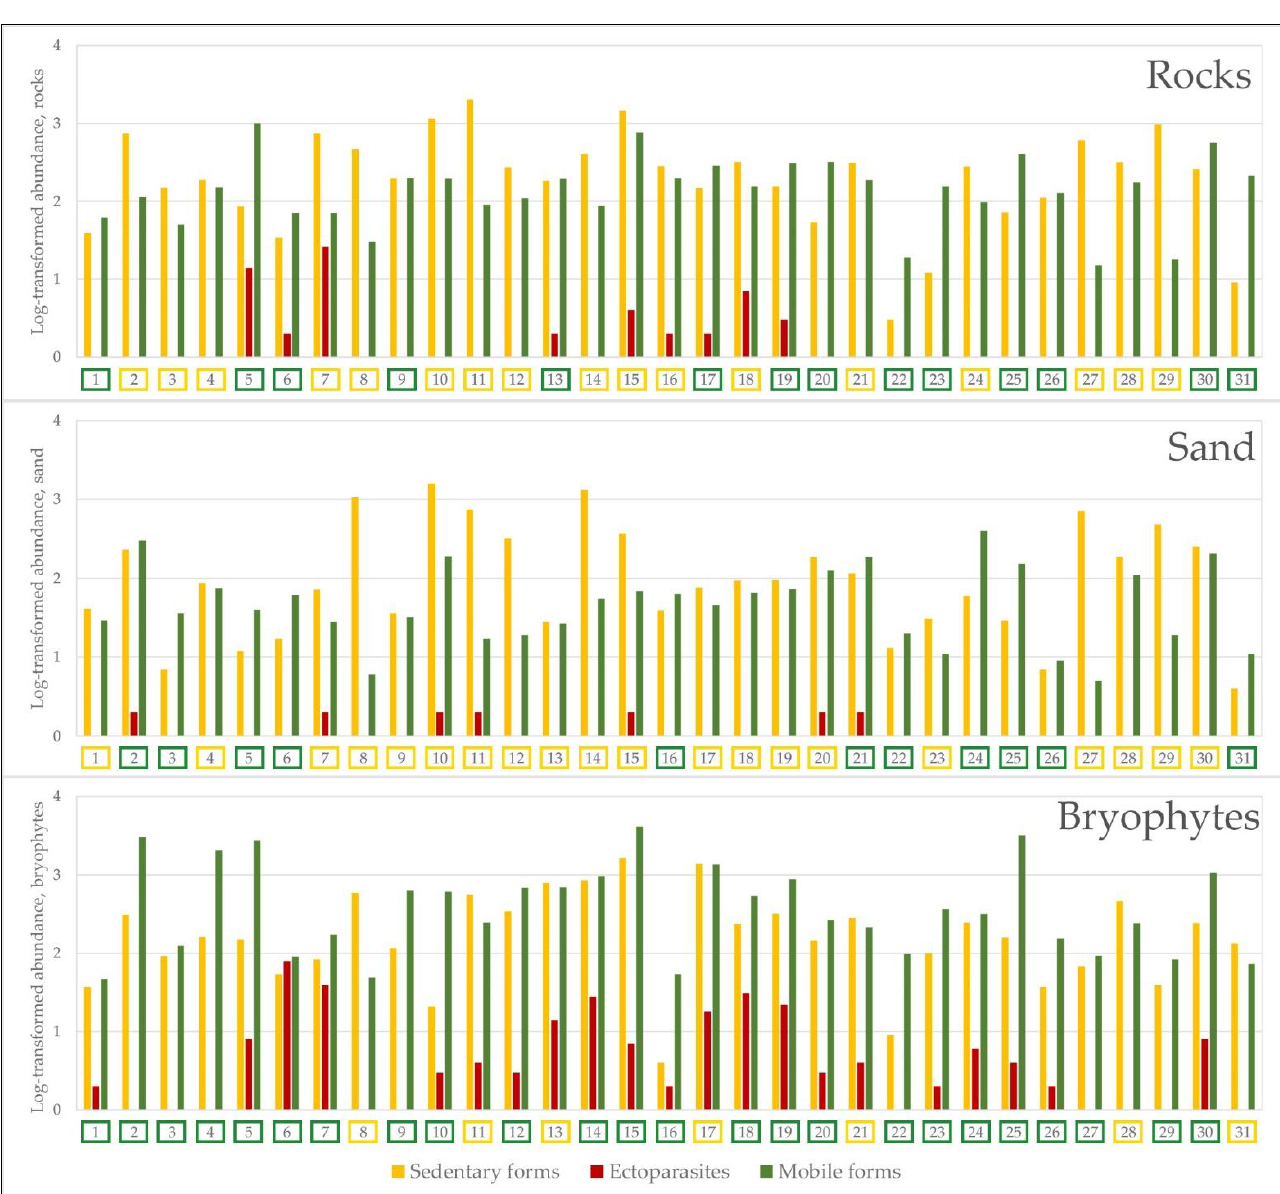
Figure 5. Relative abundance of crenic invertebrate guilds, labeled as sedentary, ectoparasitic, and mobile on rocks (top), sand (middle), and bryophytes (down); the abundance values were transformed as follows: log(value + 1); numbers in orange squares: springs with a higher number of sedentary forms; numbers in green squares: springs with a higher number of mobile forms; sampling codes from 1 to 31, as in Table 1.